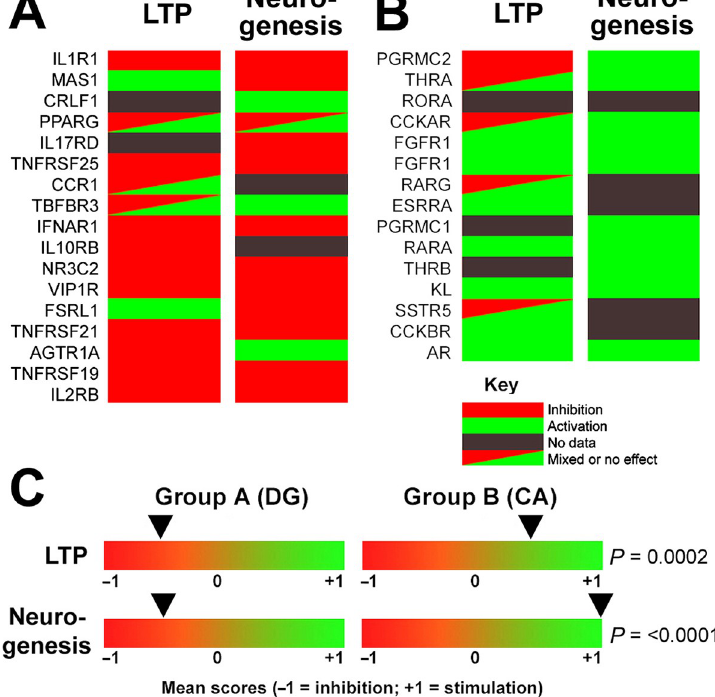
Fig 5. Differential effects of receptor activation on long-term potentiation (LTP) and neurogenesis. ( A ) Group A (DG/challenge). ( B ) Group B (CA/sufficiency). Individual genes are ordered as in Figs 3 and 4. ( C ) Mean scores for the two groups, demonstrating that group A receptors tend to suppress both LTP and neurogenesis, whereas group B receptors tend to promote both parameters. The differential patterns of stimulation/inhibition of LTP and neurogenesis were highly significant between the two